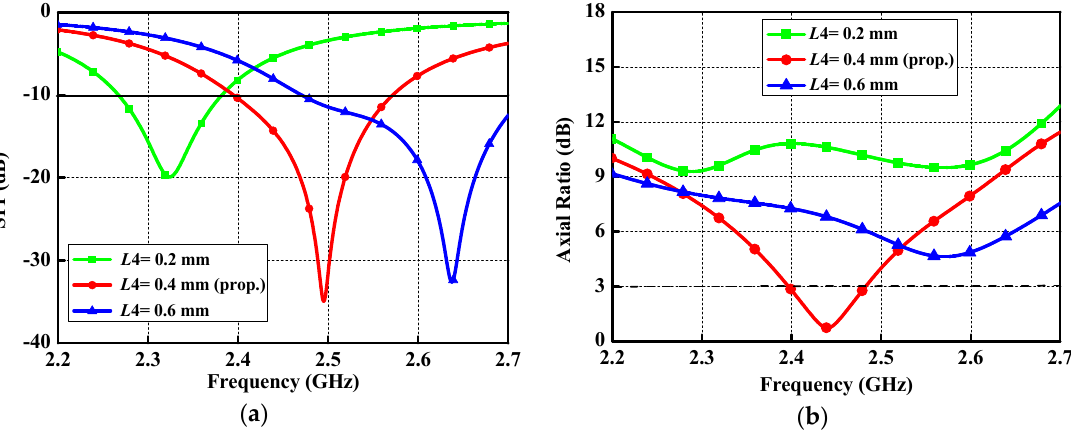
Figure 9. Current distributions on the patch at: ( a ) t = 0T; ( b ) t = T/4; ( c ) t = T/2; and ( d ) t = 3T/4.